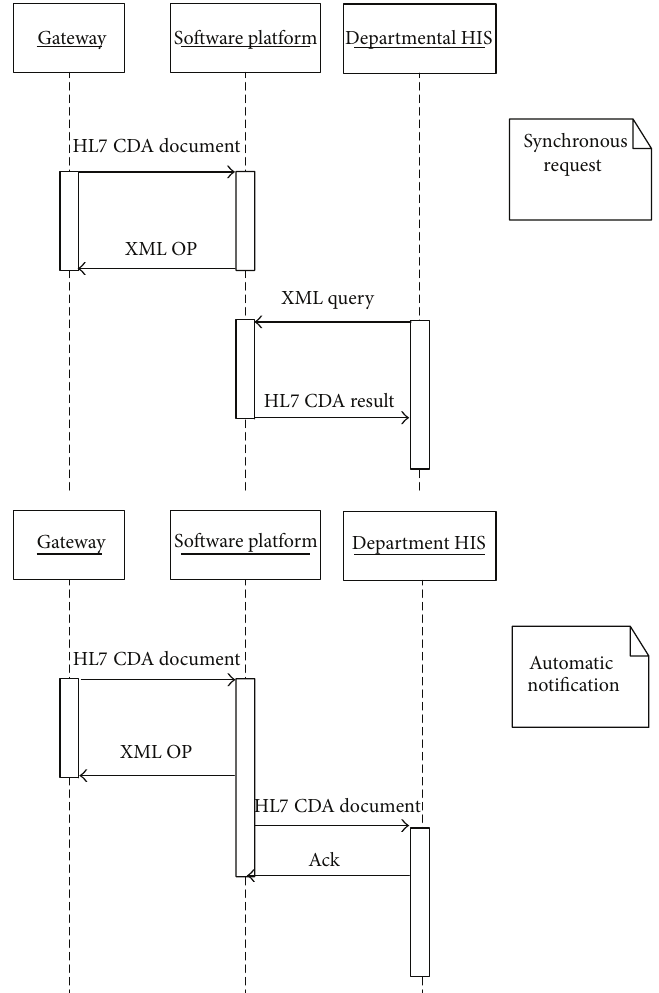
Figure 10: Methods of integration between the H@H software platform (server side) and the departmental HIS. The communication between the H@H home gateway and the server software platform is the same in both